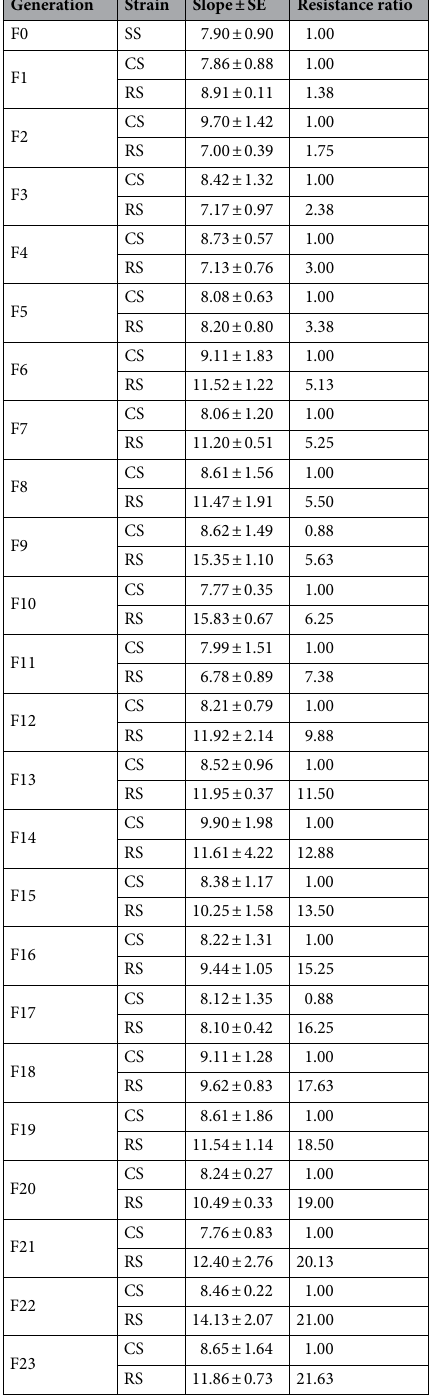
Table 1. Resistance development of German cockroaches from F0 to F23 generation selected by CPF. Data were pooled from three independent experiments and subjected to regression/probit analysis using SPSS 13.0 to estimate the slope, 50% lethal dose (LD 50 ), then the mean and SE were calculated. Resistance ratio = LD 50 (CS) or